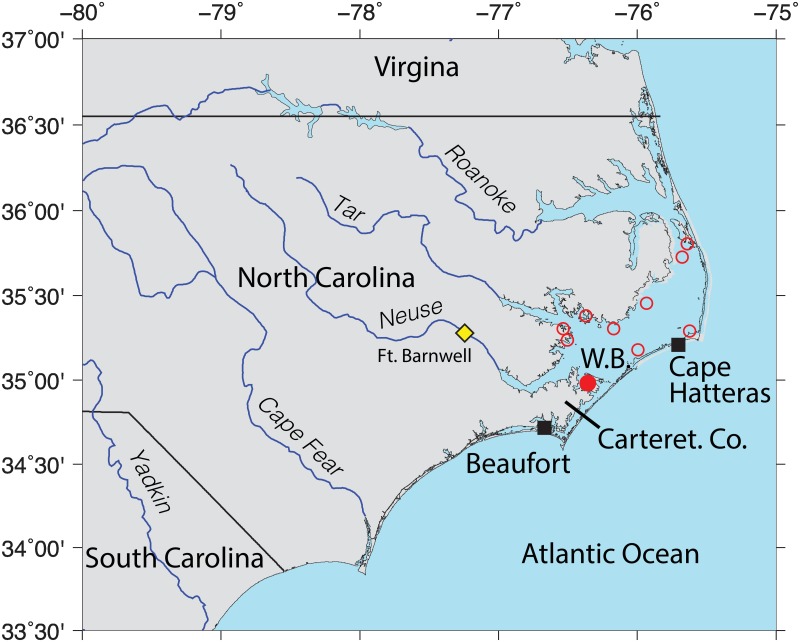
Location Map.Oyster reserve sites in Pamlico Sound, North Carolina, USA (open red circles), including the West Bay Marine Reserve (solid red circle) that was acoustically monitored semi-continuously over the period between 18 June 2011 and 06 July 2012. Water temperature and atmospheric data are available from long-term NOAA monitoring sites in Beaufort and Cape Hatteras NC (black squares). Neuse River discharge data were collected near Fort Barnwell, NC (yellow triangle).